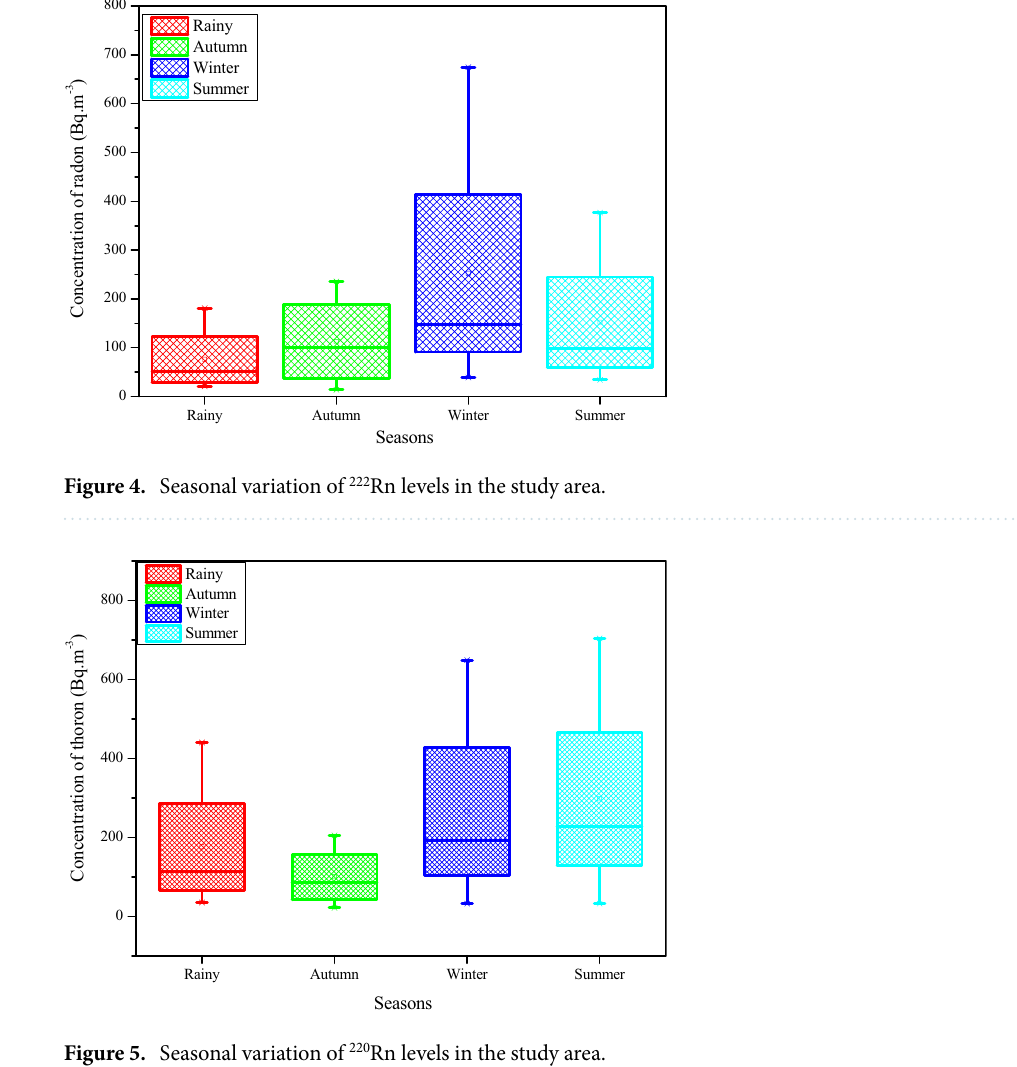
Figure 5. Seasonal variation of 220 Rn levels in the study